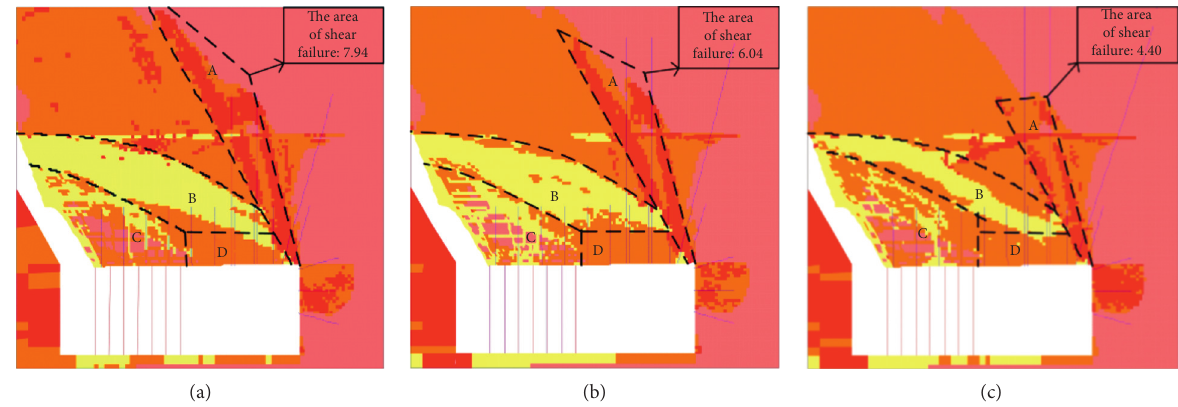
Figure 15: Cable length influencing the shear failure around removal area. (a) 6.1m. (b) 8.1m. (c) 10.1 m.